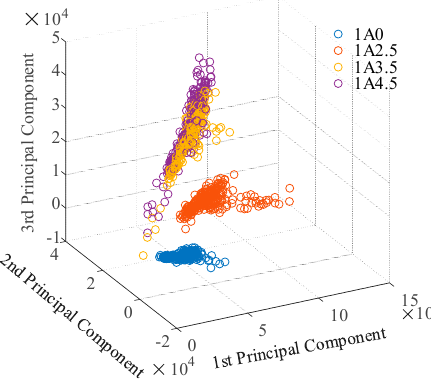
Figure 16. Distribution of spectral sets of samples for different tracking and erosion resistance performance in the new coordinate space.